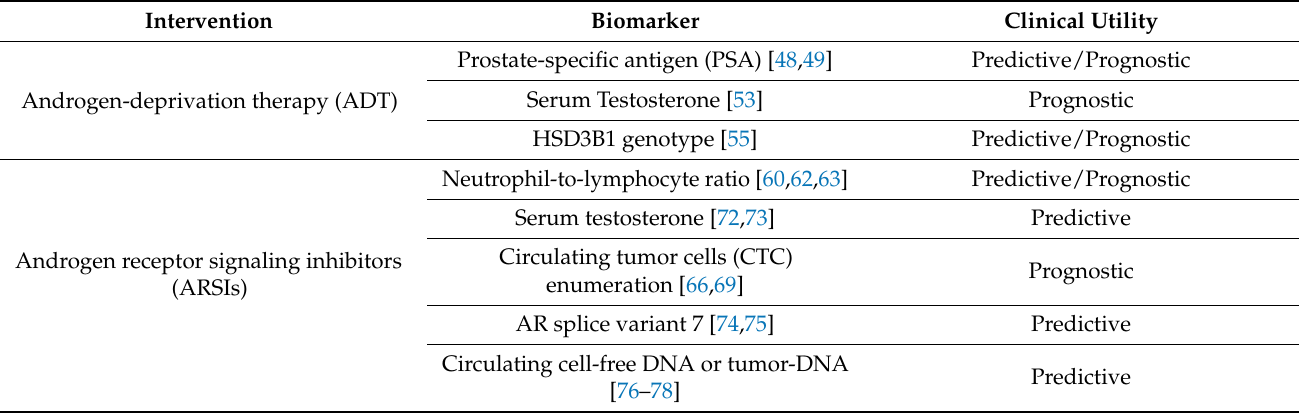
Table 2. Biomarkers in management of metastatic prostate cancer based on treatment strategy. (References in parenthesis).